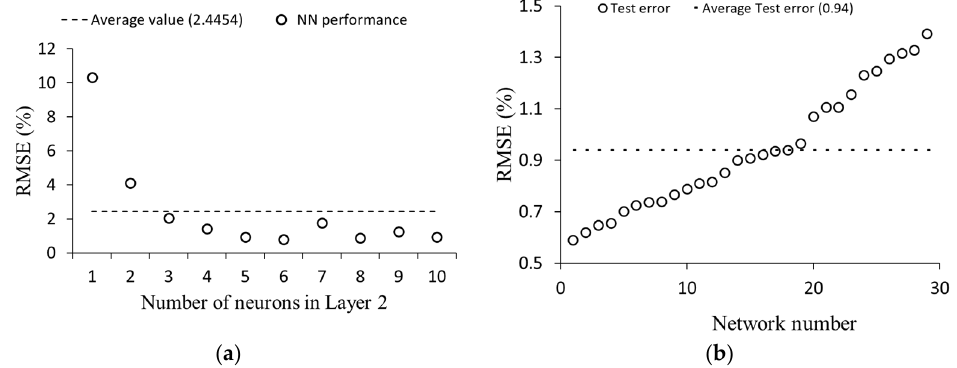
Figure 8. ( a ) influence of number neurons in the second layer on network performance; ( b ) the av- erage performance of the neural network. average performance of the neural